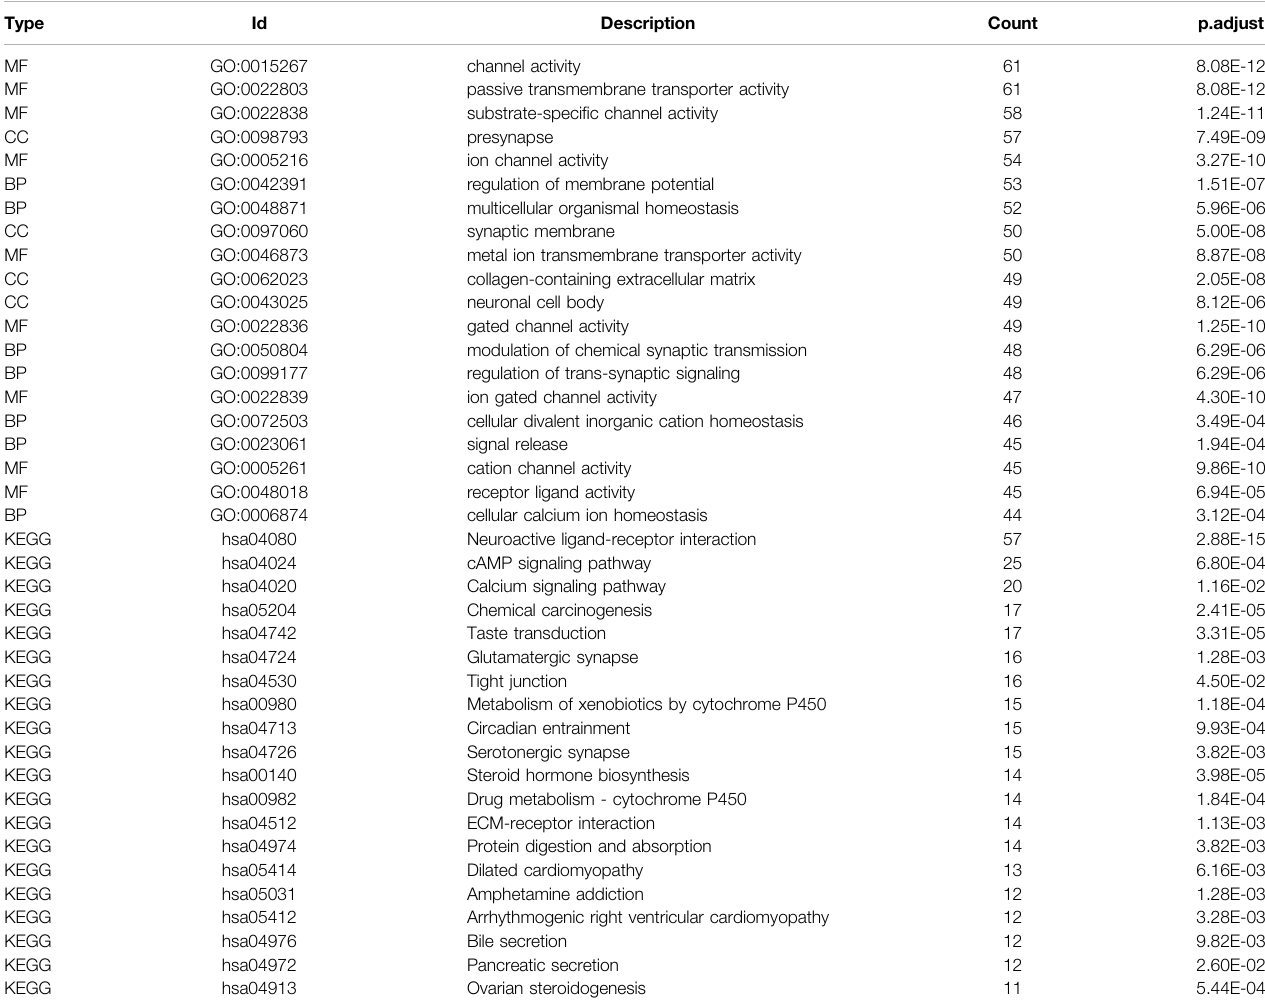
TABLE 2 | GO and KEGG analysis of DEGs in the MDN1 mutant and wild-type groups. Type Id